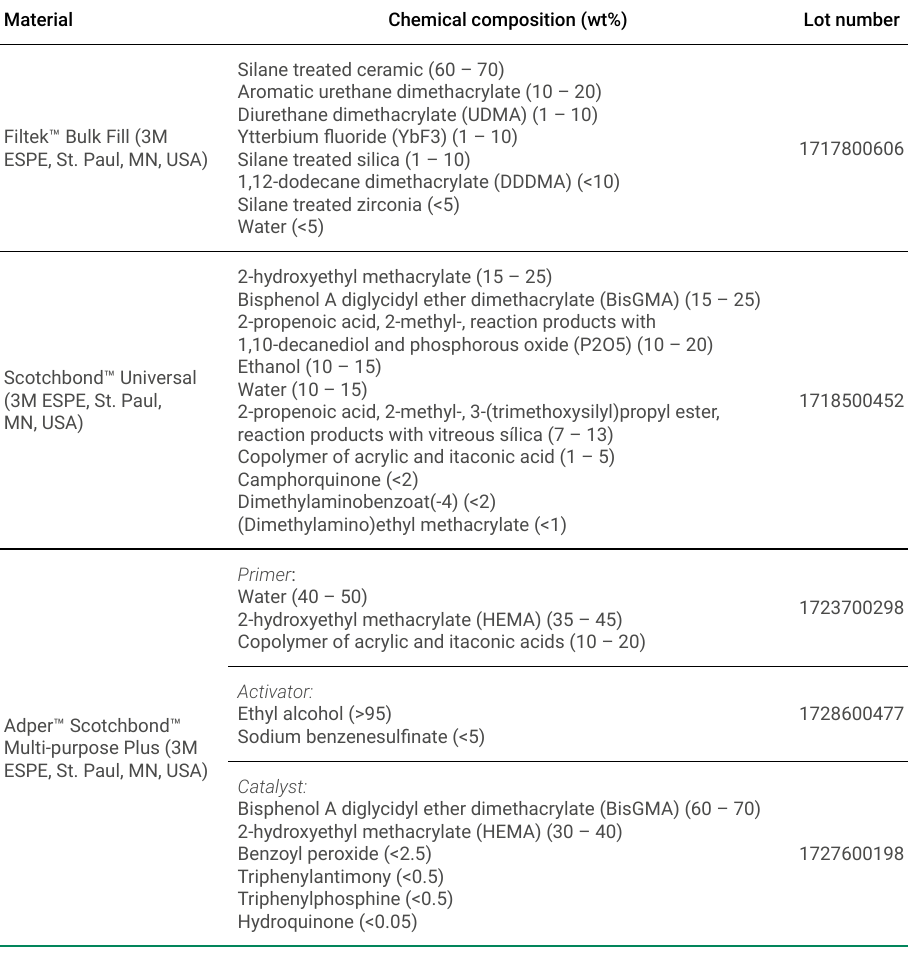
Table 1. Materials used in this study. Material Chemical composition